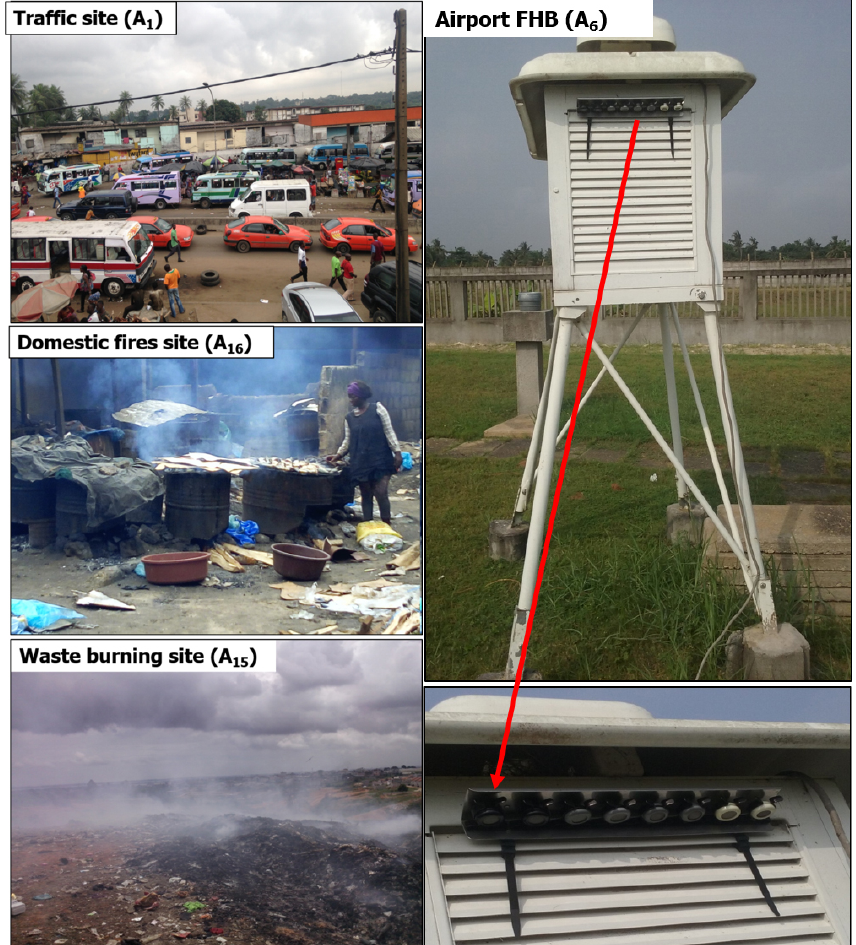
Figure 2. Photos of different sampling sites using INDAAF passive samplers installed in duplicate: traffic (A 1 ) , domestic fires (A 16 ) waste burning (A 15 ) and airport FHB (A 6 )